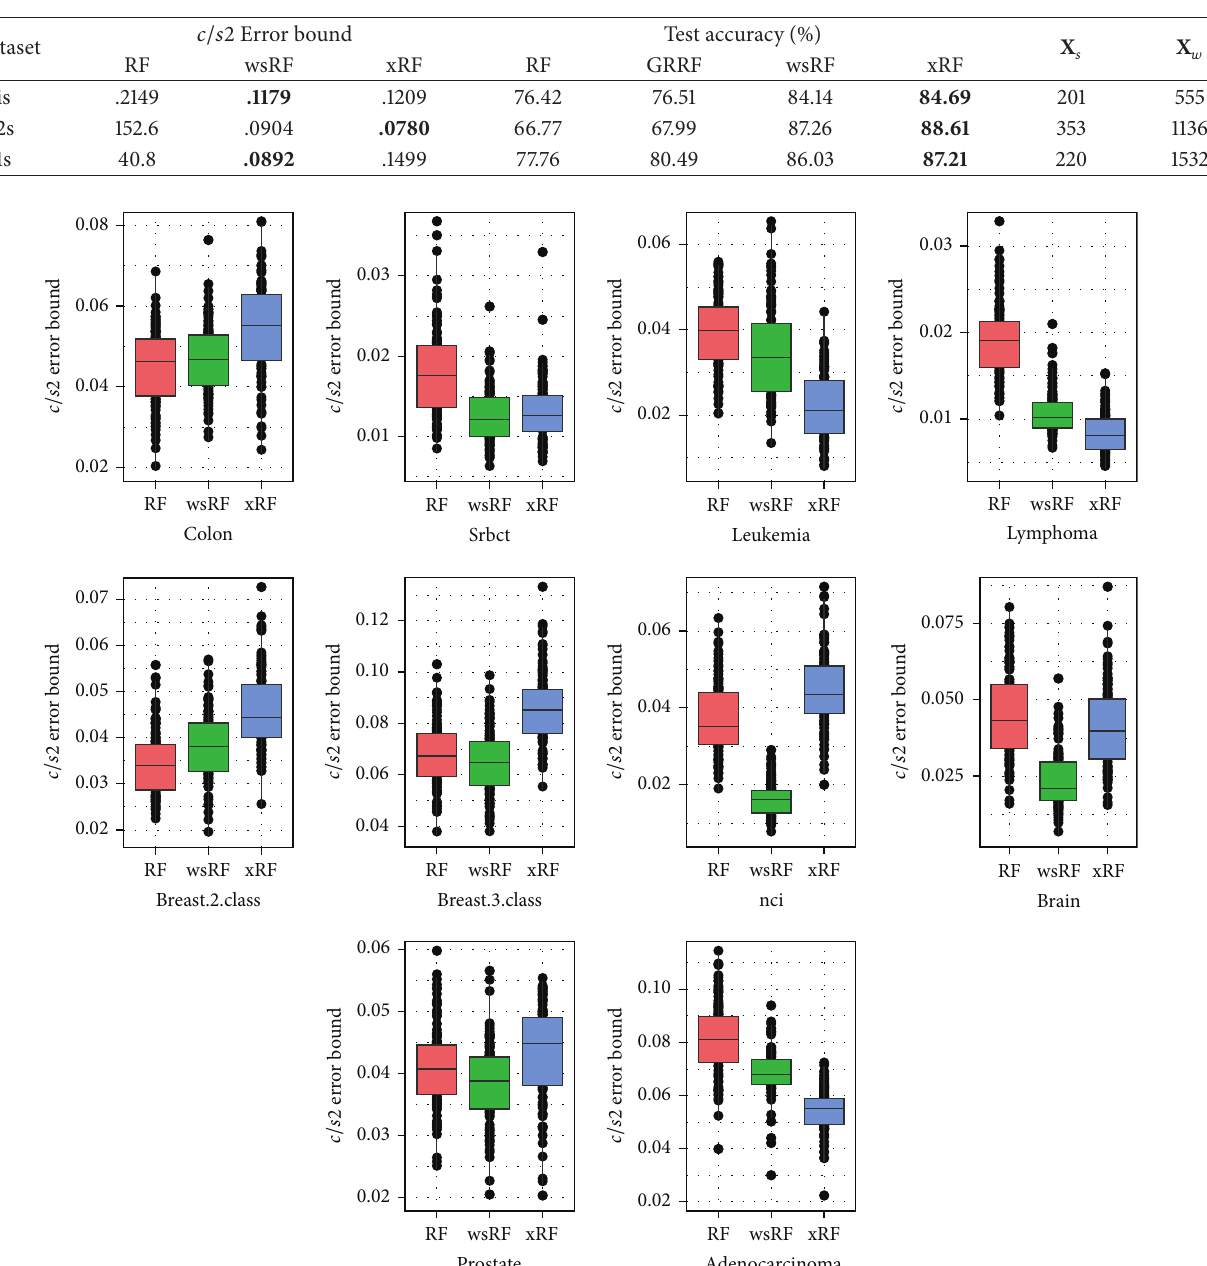
Figure 8: Box plots of ( 𝑐/𝑠2 ) error bound for the models applied to the 10 gene